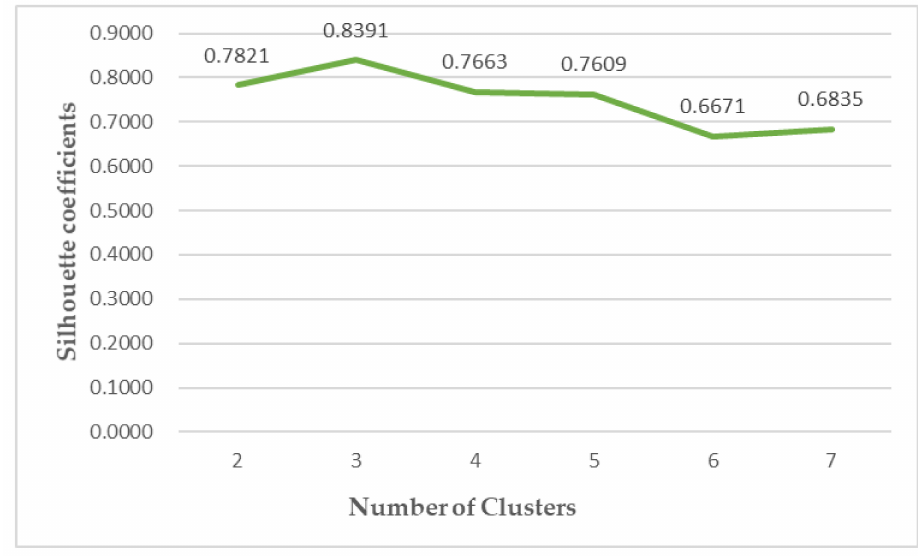
Figure 7. Silhouette coefficients of clusters.